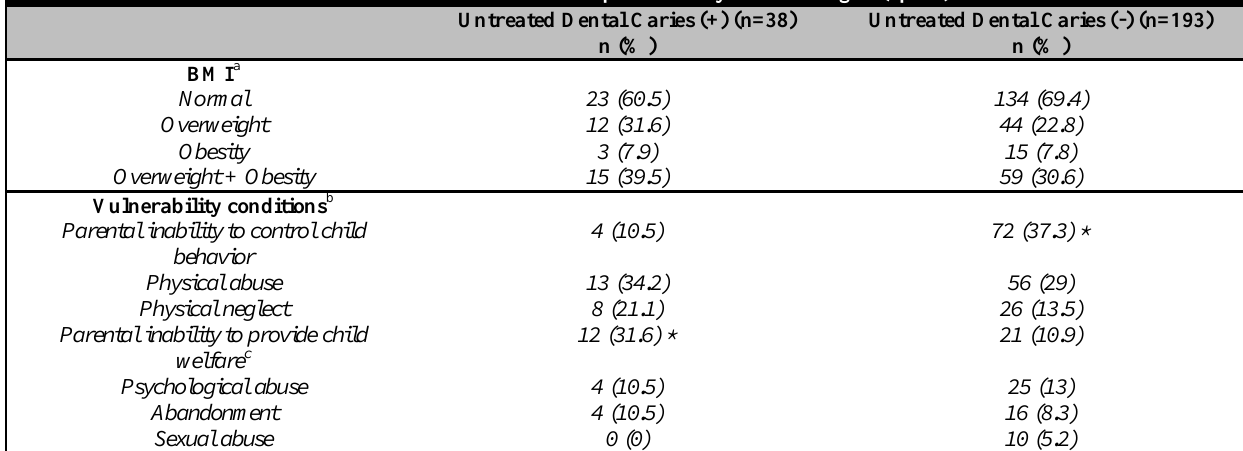
Table 4. Comparison of the prevalence of untreated dental caries with BMI and the vulnerability conditions of 231 Latin American children in the child protection system of Aragon (Spain) Untreated Dental Caries (+)